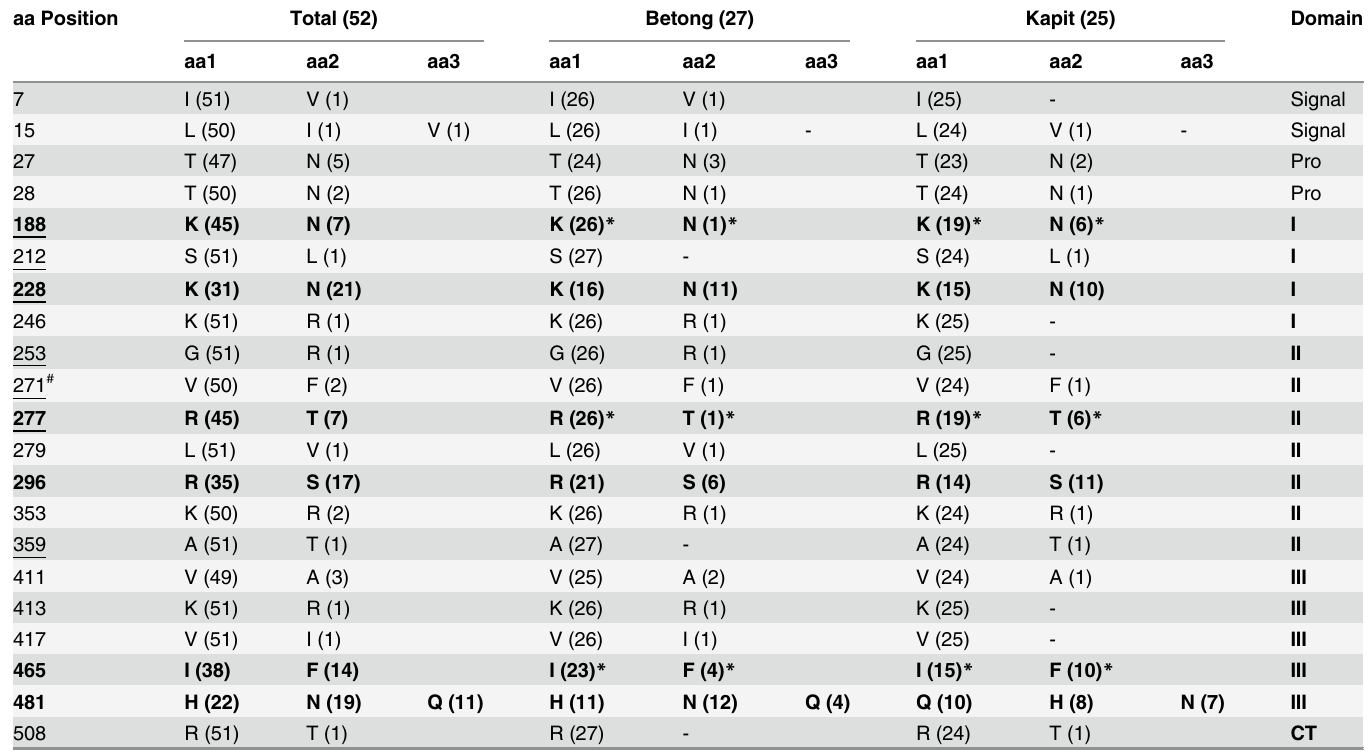
Table 1. Polymorphism in the PkAMA1 protein, total and per